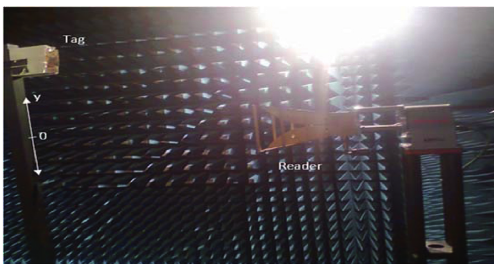
Figure 9: Test setup for the measurement of minimum tag turn on power when the tag is placed in the free space.